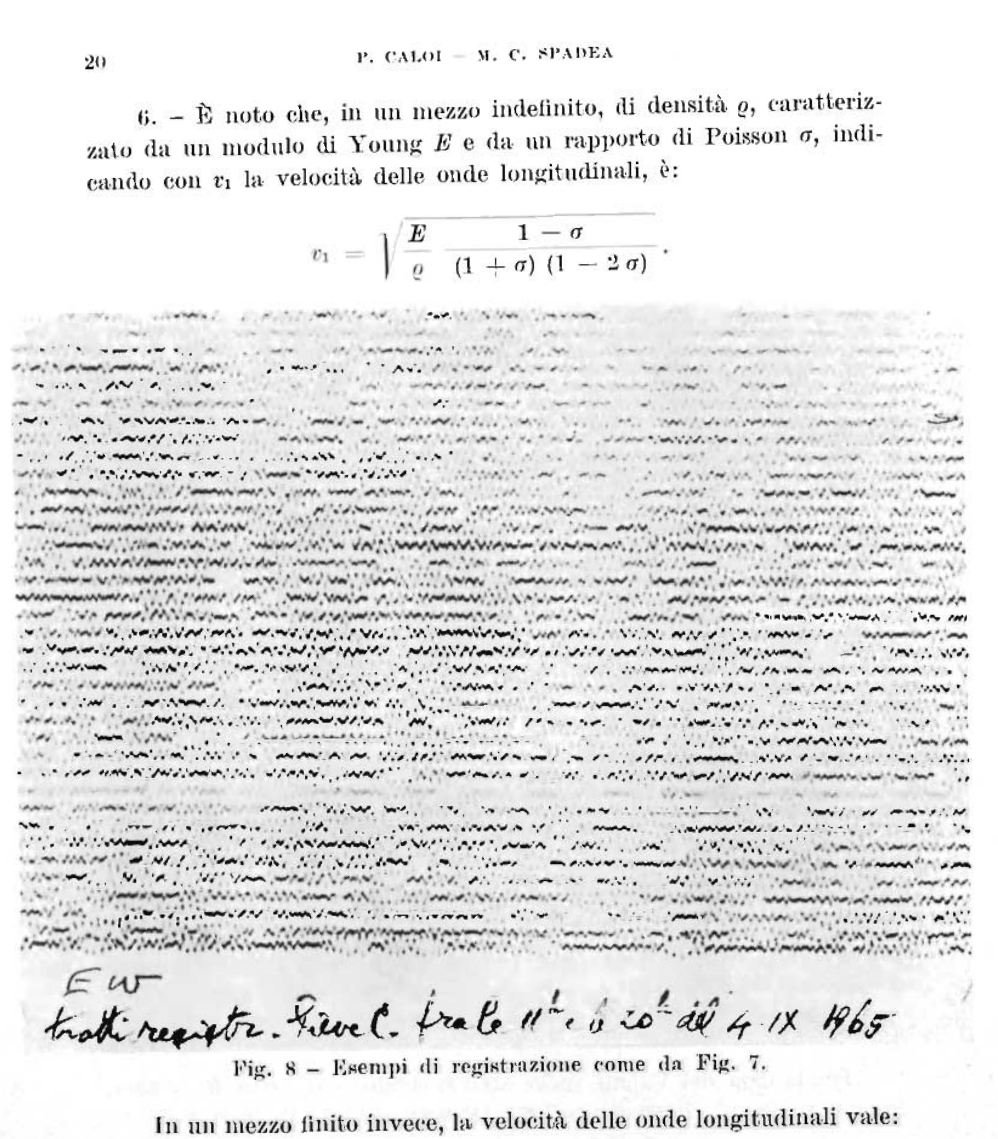
Fig. 8 Esempi di registrazione come da Fig. 7. In 1111 mezzo finito invece, la velocità delle onde longitudinali vale: Vi